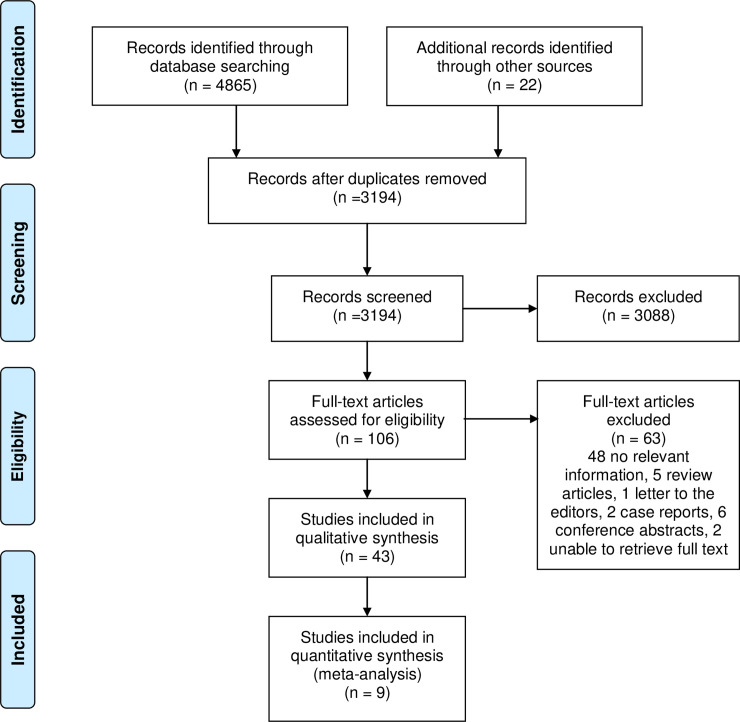
PRISMA 2009 flow diagram of included studies.Adapted from Moher et al. [23].